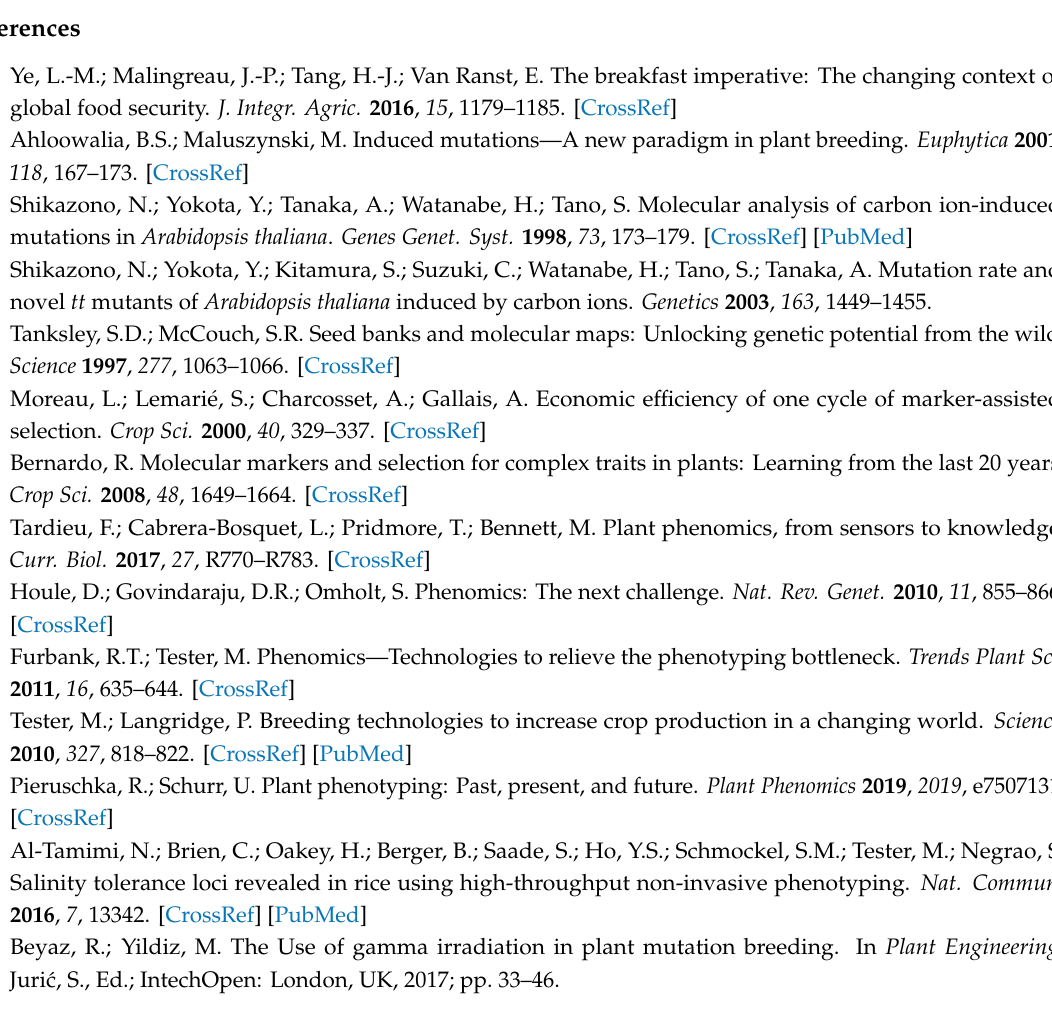
( n = 100). Figure S4: Comparing projected area (PA) of four irradiated Arabidopsis populations on multiple days after sowing (DAS). Figure S5: Comparing phenotypes of Arabidopsis seeds irradiated at 100 and 200 Gy of gamma radiation ( 60 Co). Panel A: Projected area (PA). Panel B: Convex hull area (CA). Panel C: Perimeter length (PL). Figure S6. Comparing growth pattern of Arabidopsis irradiated seeds among the preliminary, the main, and the validation studies. Results were means of preliminary ( n = 100), main ( n = 120), and validation ( n = 120) studies. The 200 Gy at preliminary study: Prel_200 Gy, wild type at main study: Main_WT, 200 Gy at main study: Main_200 Gy, wild type at validation study: Vali_WT, 200 Gy at validation study: Vali_200 Gy., Figure S7. Analysis of phenotypes (PA, CA, PL) with principal component analysis (PCA) of non-irradiated and irradiated (200 Gy) populations and selected phenotypes. Panel A: PCA result from the main study. Selected image of wild type plant is colored as green square box and 200 Gy plant as purple square box. Panel B: PCA result from the validation study. Panel C: Comparison of geometric shapes (red lines) of WT (left) and 200 Gy (right). Blue dashed lines indicate relative angles between the first two true leaves. Table S1: Comparison of multiple digital phenotyping measurements in three trials (preliminary, main, and validation) at 15, 19, 20 days after sowing (DAS). Values in the same column followed by a di ff erent letter are significantly di ff erent ( p < 0.05). PA: Projected area. Table S2: Comparing absolute growth rate (AGR) of four irradiated Arabidopsis populations on multiple day after sowing (DAS). Results are means ± SD ( n = 128). Table S3. Summary of all phenotyping data from preliminary, main, and validation